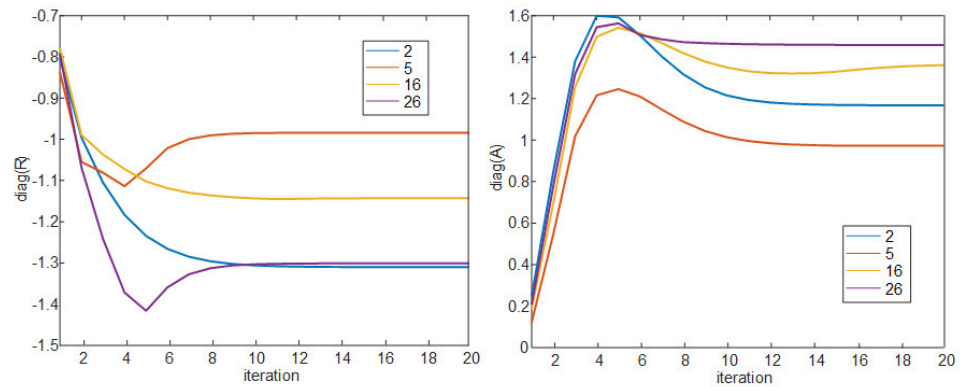
Figure 3. Diagonal component values of R , A matrix by iteration in Algorithm 1 (2, 5, 16, and 26 data